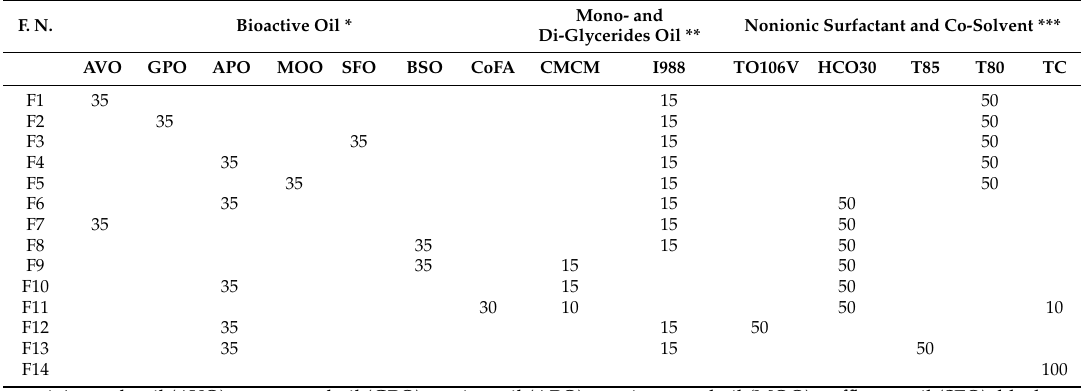
Table 2. Formulation composition using various fruit oils, medium- and long-chain mixed glycerides, and non-ionic surfactants. The excipients are mixed as % ( w / w ). F. N. Bioactive Oil * Mono- and Di-Glycerides Oil